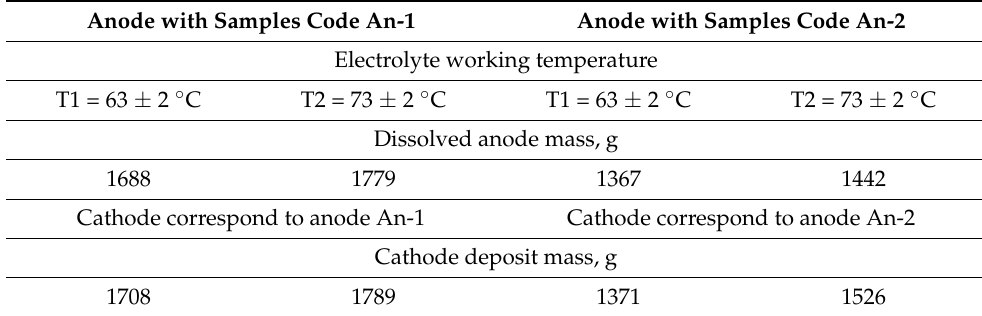
Table 2. Mass of dissolved copper anodes and cathode deposit